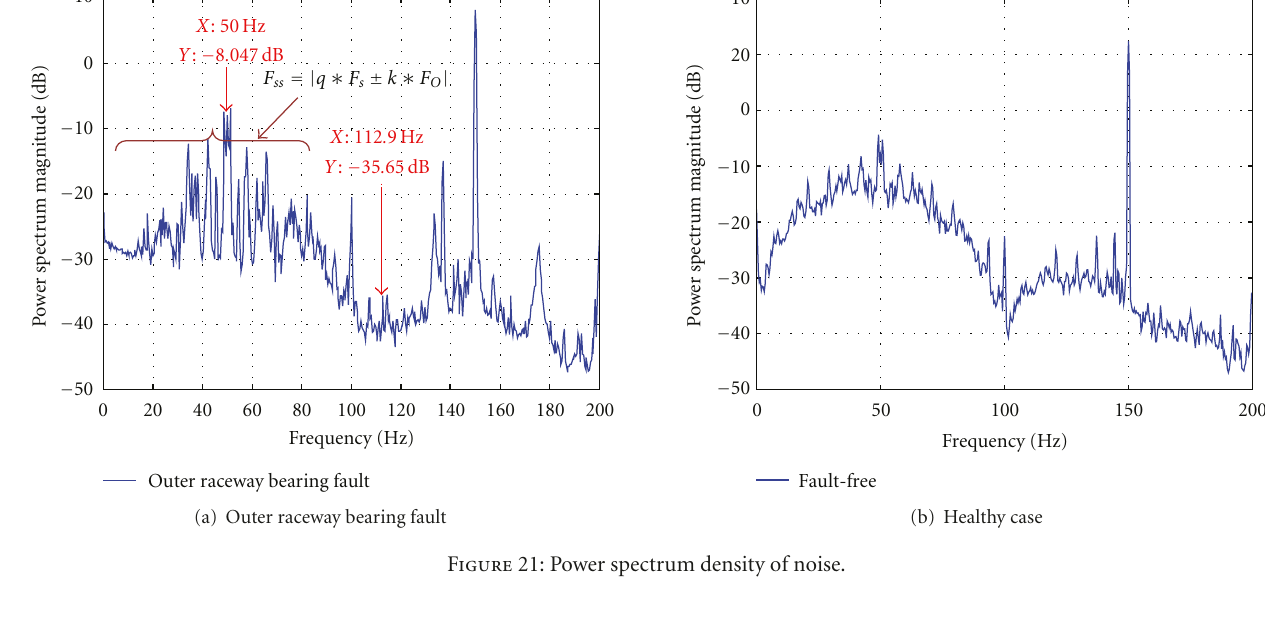
Figure 21: Power spectrum density of noise.